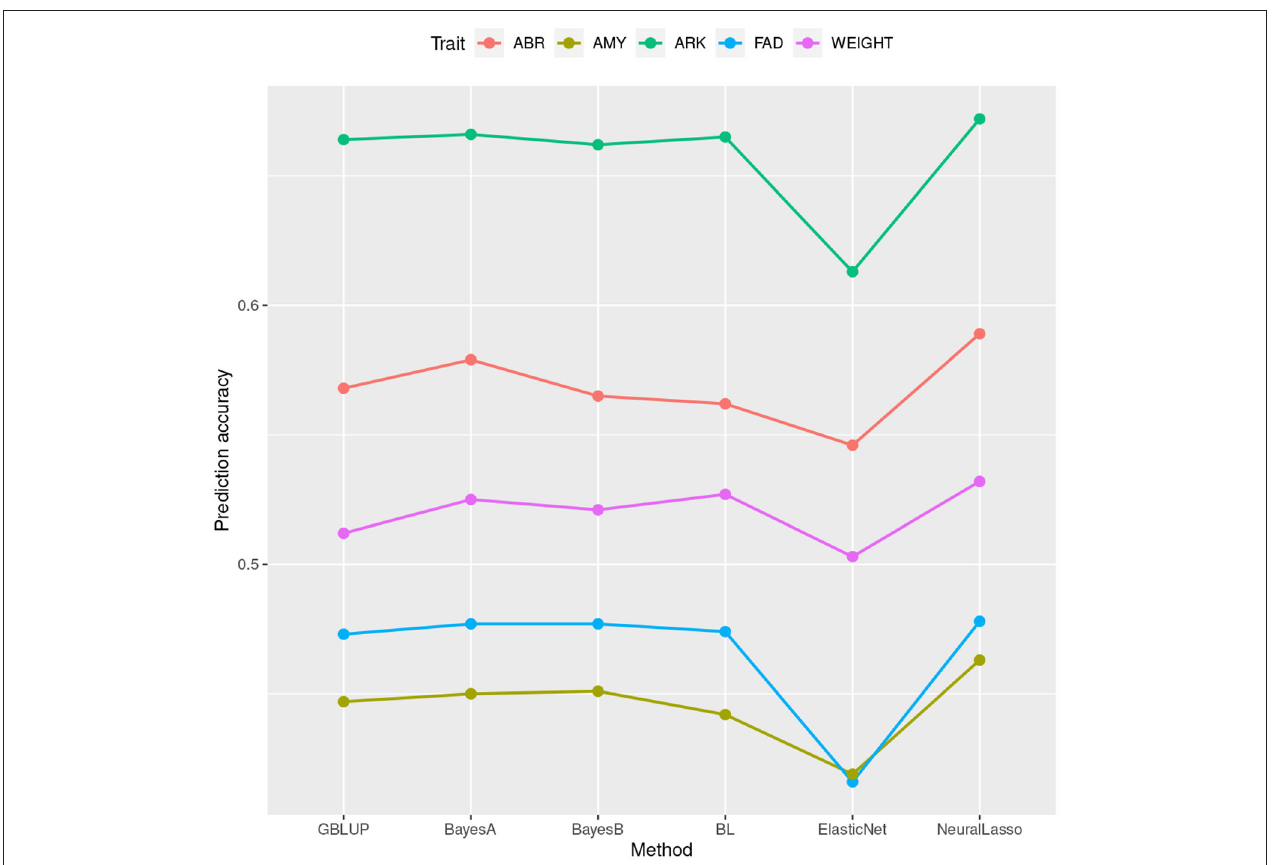
FIGURE 1 | Mean prediction accuracy calculated based on 50 cross validations for different traits from the rice and mice data sets plotted against the corresponding estimation